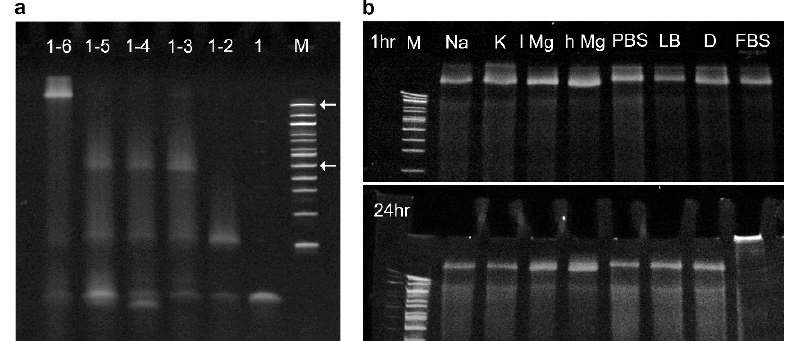
Figure 2. The DNA nanopores fold efficiently and remain structurally stable in a range of salts and buffer conditions as shown by gel electrophoresis. Sodium dodecyl sulfate polyacrylamide gel electrophoresis (SDS-PAGE) reveals ( a ) step-wise assembly of NP-0C, left to right, fully assembled barrel strands ( 1–6 ), followed by component strands ( 1–5 ), ( 1–4 ), ( 1–3 ), ( 1–2 ), ( 1 ), and 100 base pair marker ( M ), the arrows indicate the 1517 ( top ) and 500 base pair ( bottom ) marker bands; ( b ) 1 h ( top ) and 24 h ( bottom ) after folding of NP-0C assembled in a variety of conditions; 100 base pair marker ( M ), 0.3 M sodium chloride ( Na ), 0.3 M potassium chloride ( K ), 14 mM magnesium chloride ( l Mg ), 140 mM magnesium chloride ( h Mg ), phosphate buffered solution ( PBS ), Lysogeny Broth ( LB ), Dulbecco’s modified Eagle medium ( D ), and Dulbecco’s modified Eagle medium supplemented with 10% fetal bovine serum ( FBS ).